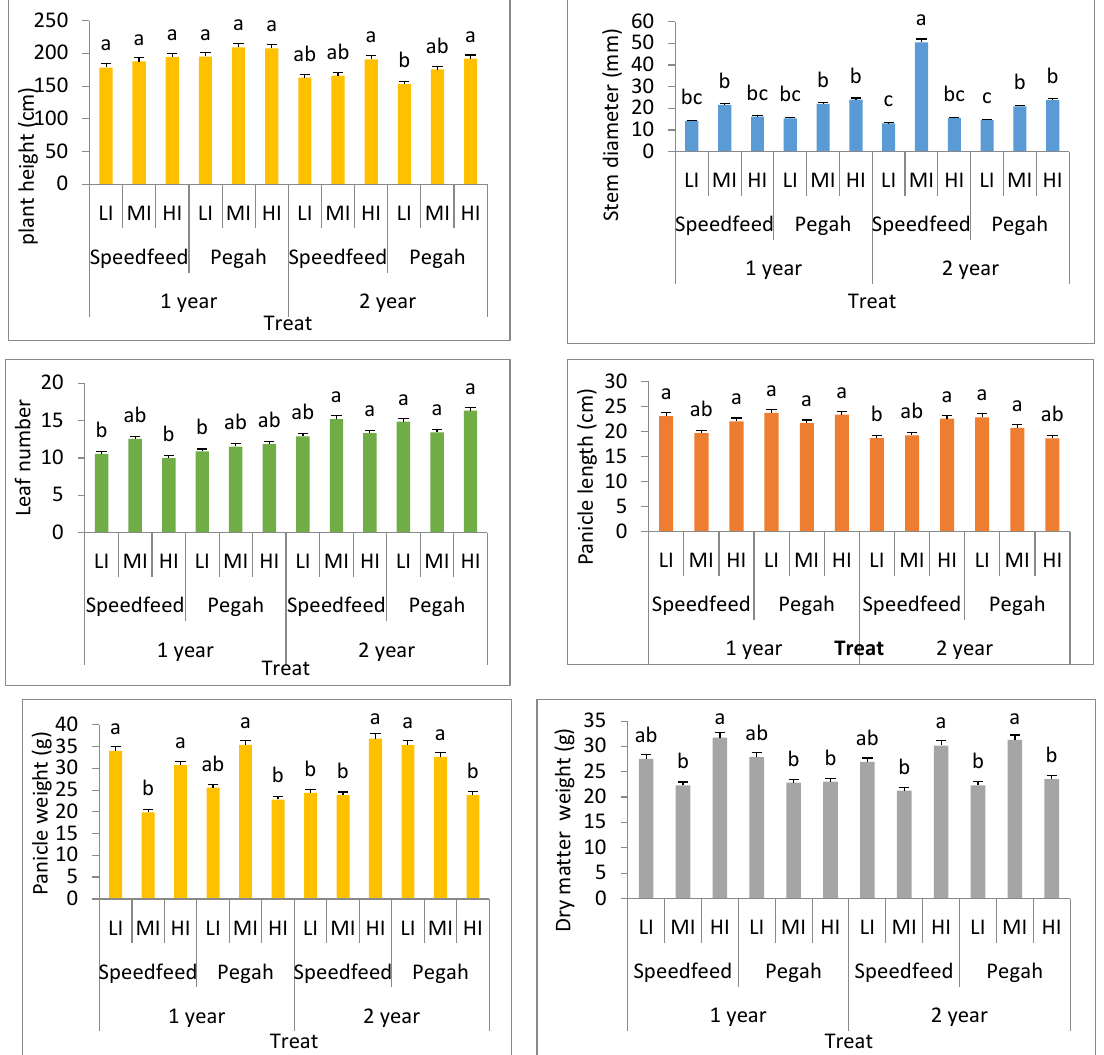
Fig. 1: Variations in morphological properties of the two varieties of sorghum at different years under different irrigation levels. Different lower-cases for interaction on the bars show significant differences (Duncan, P < 0.05). (HI): High irrigation, (MI): Medium irrigation and (LI): Low irrigation